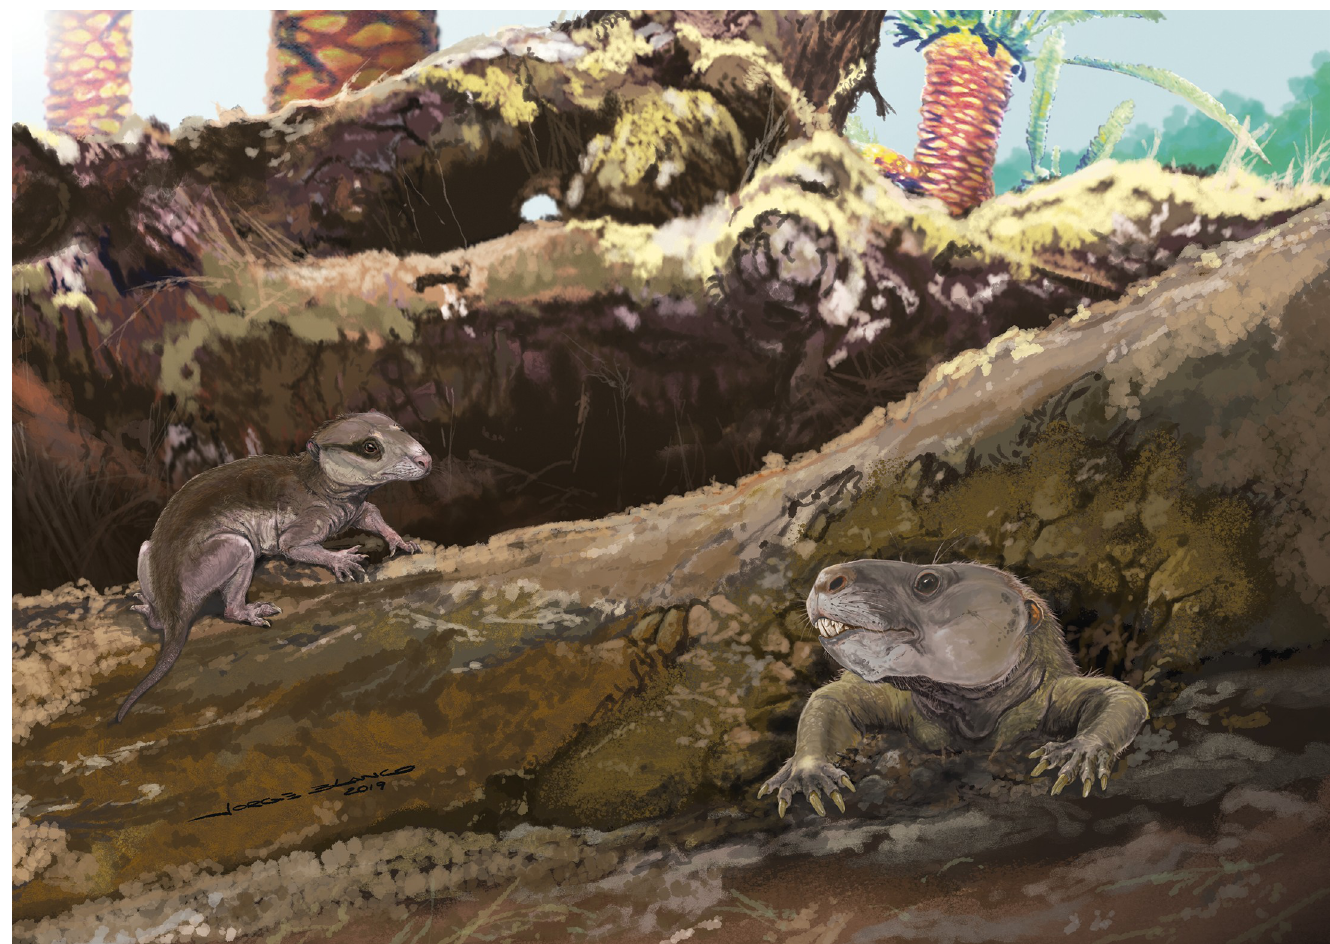
Fig 13. Paleoartistic reconstruction of Brasilodon quadrangularis (left) and Riograndia guaibensis (right), two abundant probainognathian cynodonts from the Riograndia AZ of the Candela´ria Sequence, Santa Maria Supersequence (Brazil), which exhibits different morphologies in skull, dentition and locomotor apparatus. Made by Jorge Blanco.